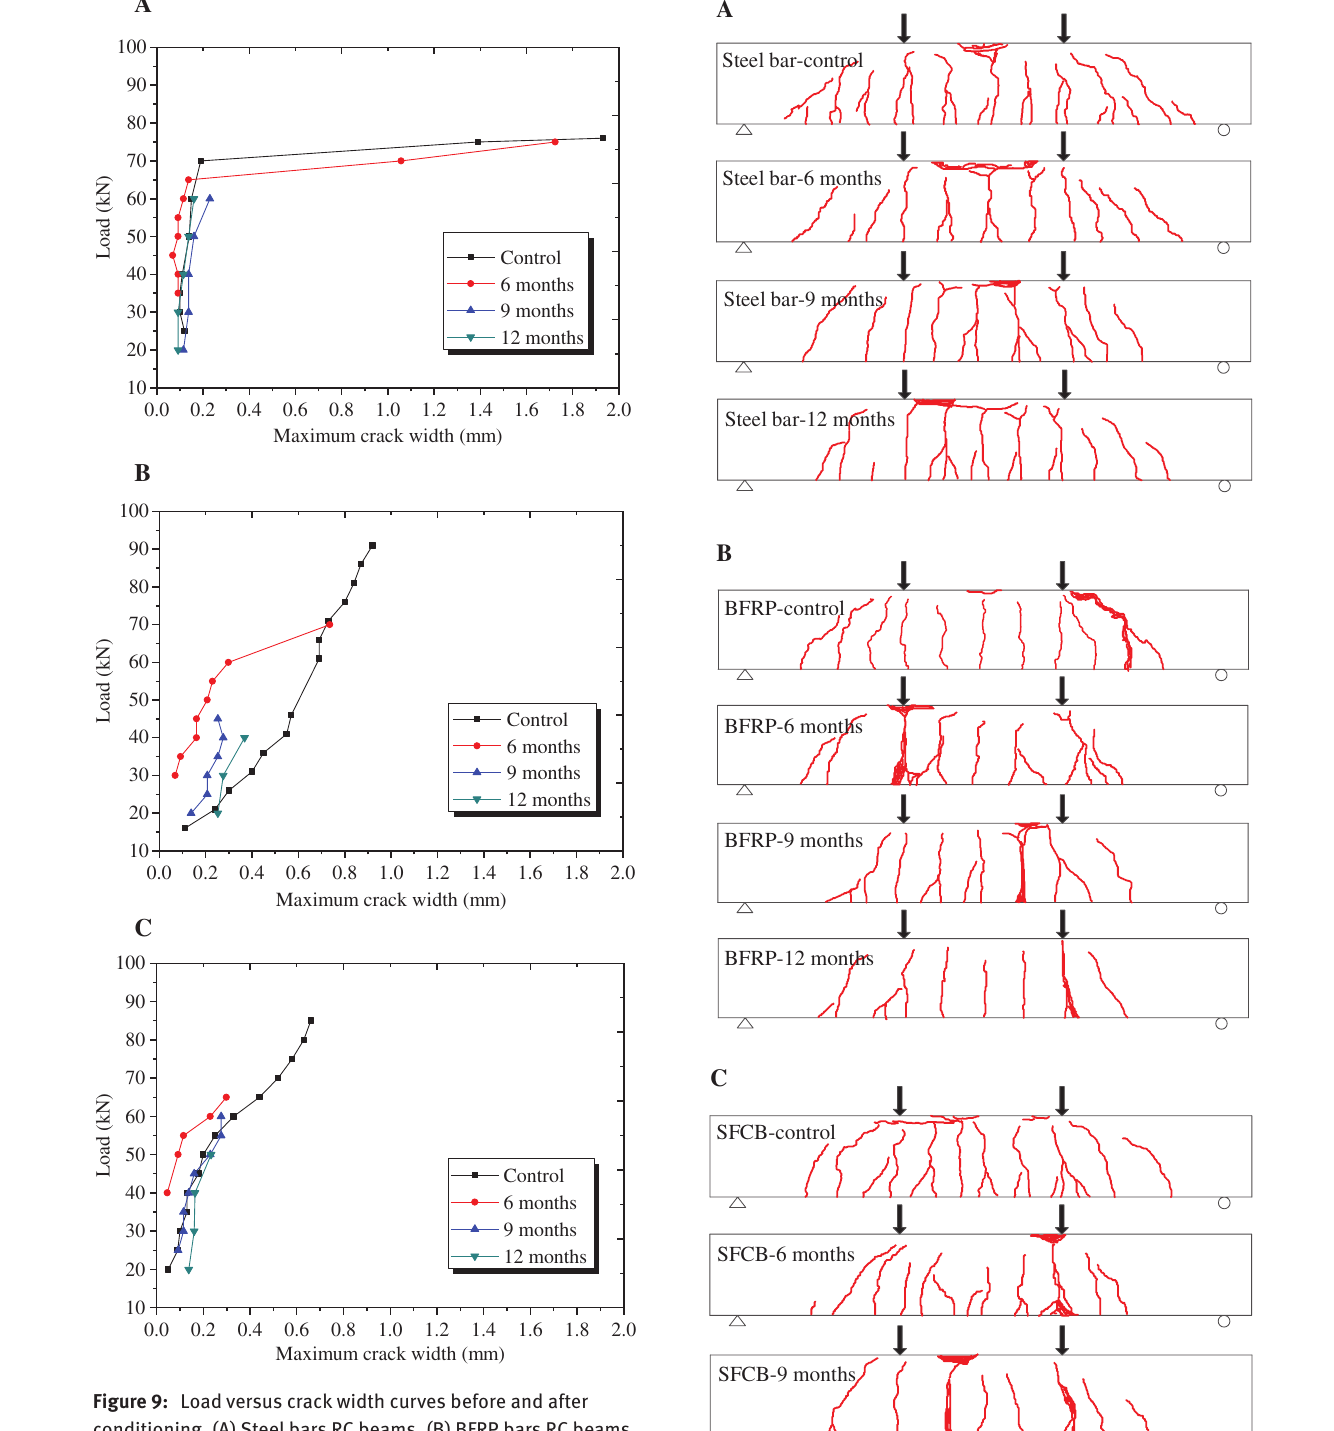
Figure 9: Load versus crack width curves before and after conditioning. (A) Steel bars RC beams, (B) BFRP bars RC beams and (C) SFCBs RC beams.